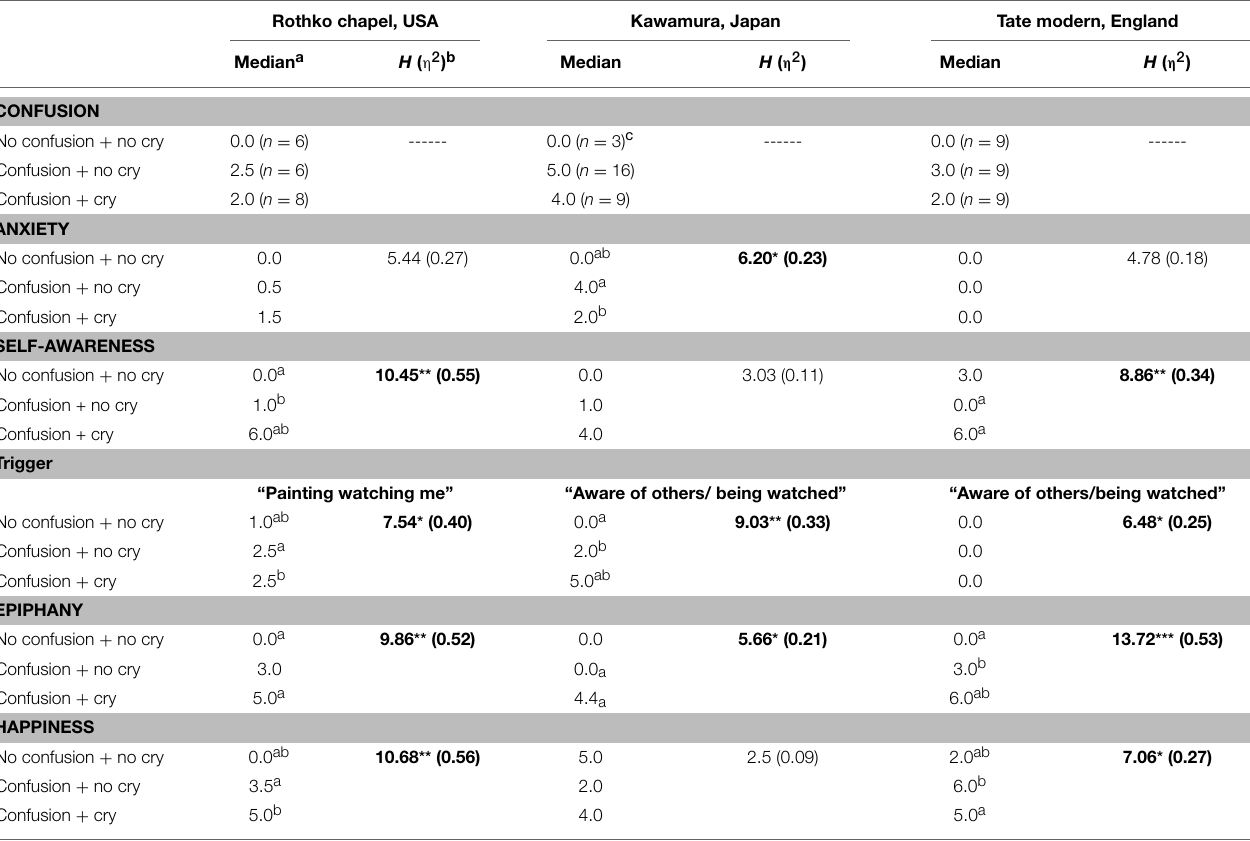
TABLE 4 | Comparison of key reported experiential factors between three hypothesized “feeling like crying/no- feeling like crying” + “confusion/ no-confusion”